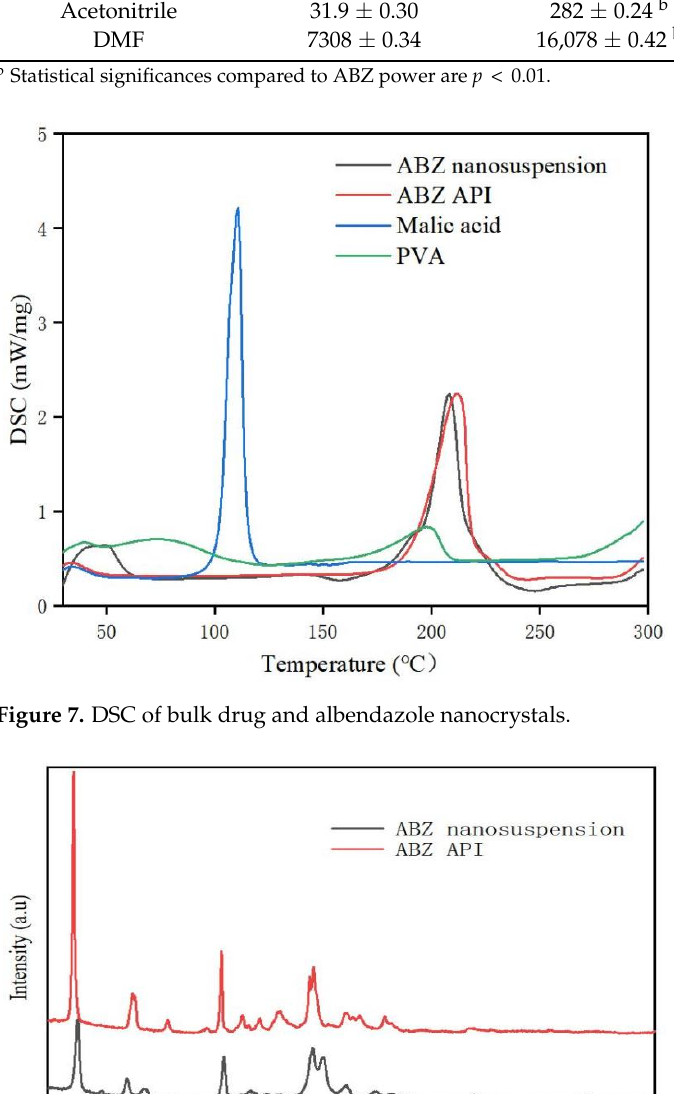
Table 2. Solubility of native ABZ and ABZ nanocrystal in various solvents (25 °C , standard atmos- pheric pressure).